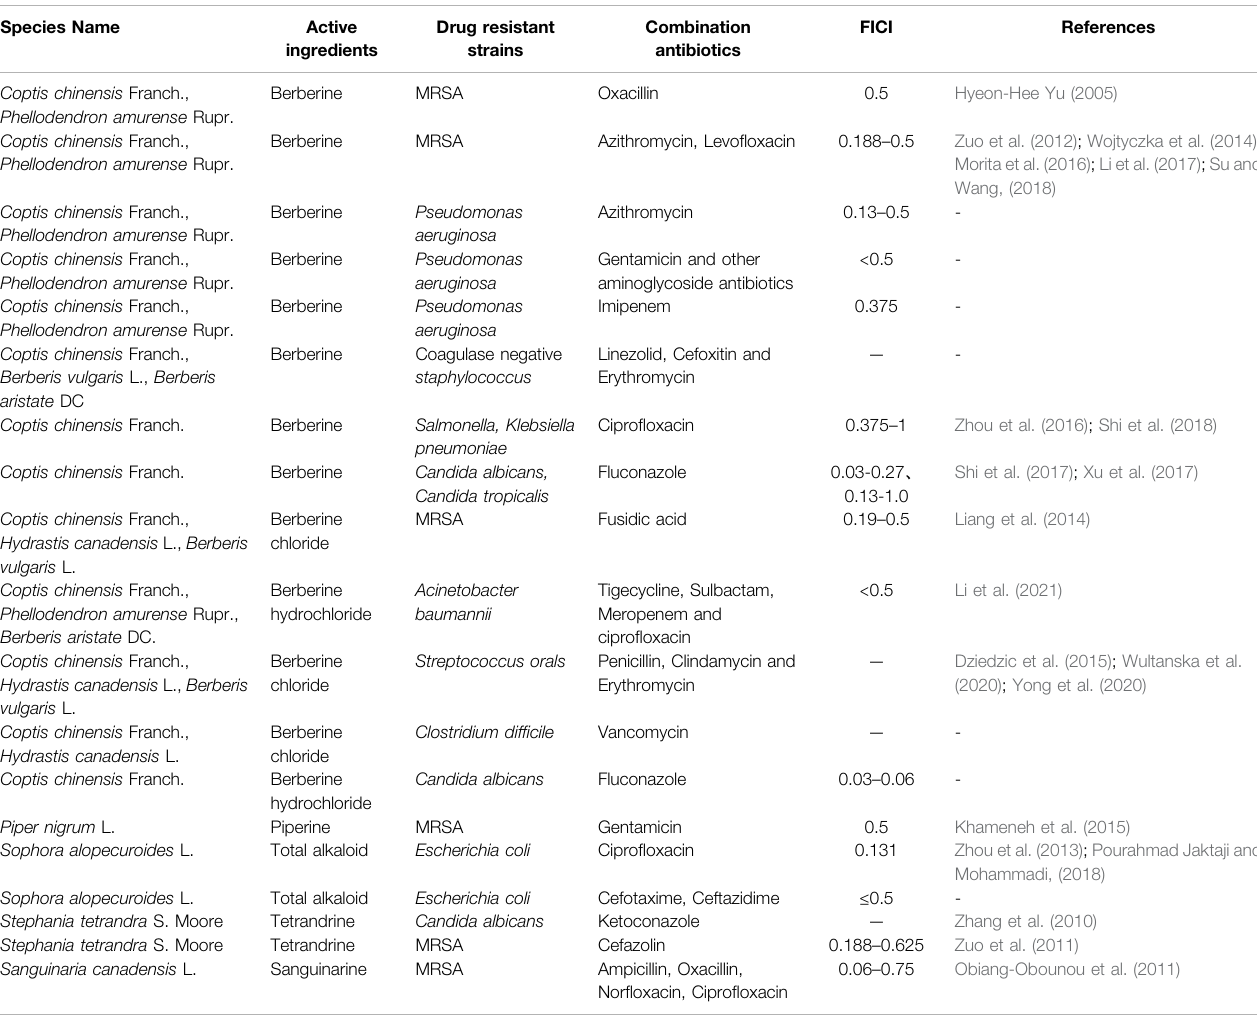
TABLE 2 | Summary of alkaloids compounds in combination with